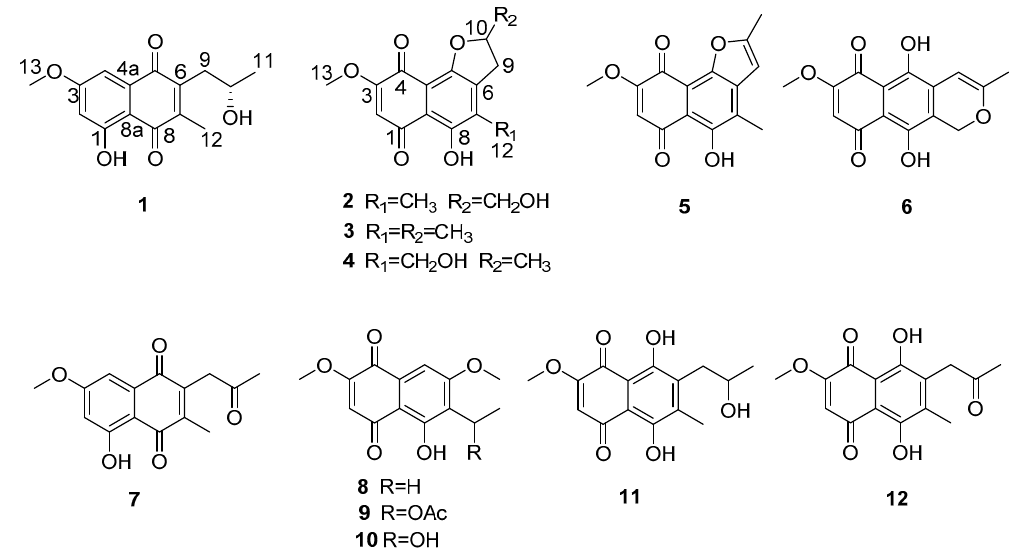
Figure 1. Structures of compounds 1–12.